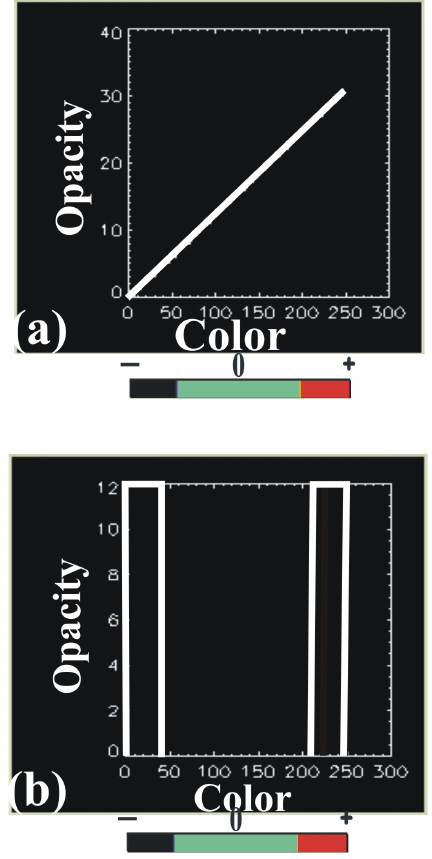
Fig. 9. (a) A linear amplitude-opacity function, (b) new amplitude- opacity